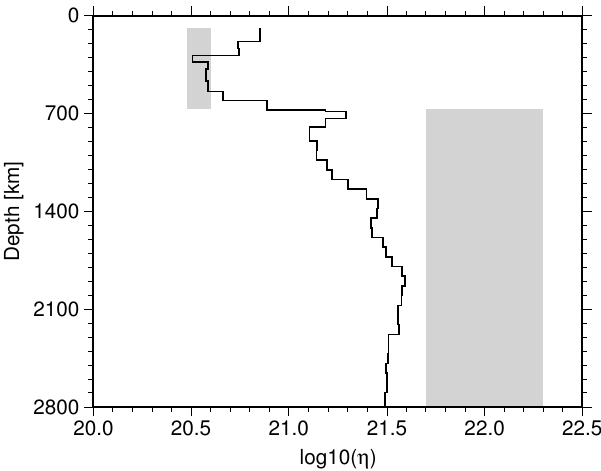
Figure 1. Viscosity profile VM2 (black line) used in the ICE-5G reconstruction and optimal two-layer viscosity range (grey regions) found in the ANU